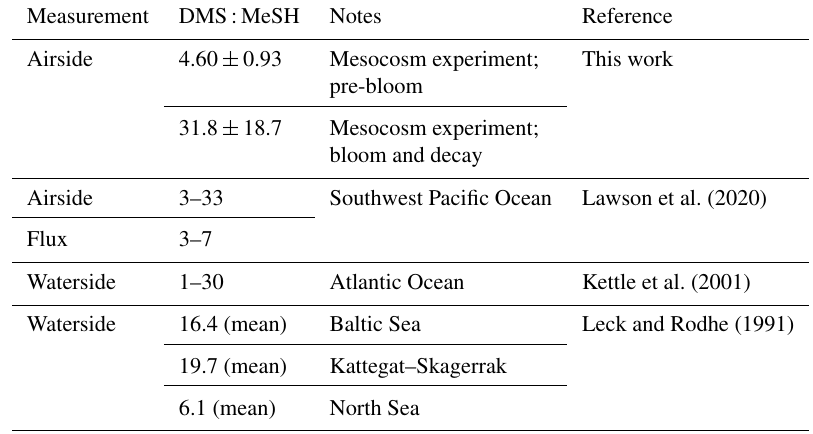
Table 1. DMS:MeSH measurements from this work and previous studies.